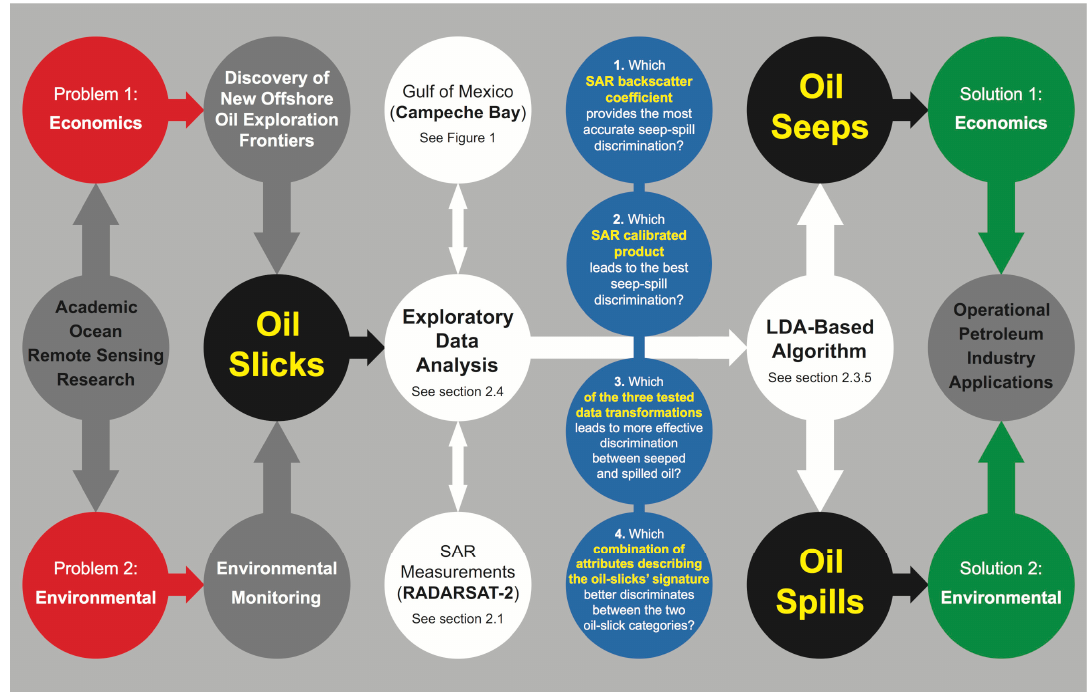
Figure 2. Research rationale of our exploratory data analysis aimed to try to improve the slick category discrimination (seeps vs. spills) using linear discriminant analysis (LDA) applied to synthetic aperture radar (SAR) measurements. Circles’ colors: gray, red, and green (bridge the knowledge of our academic ocean remote sensing strategy and operational applications of the offshore petroleum industry); black (our main objective: categorize slicks into seeps or spills); white (our exploratory data analysis: site-, data-, and algorithm-specific); and blue (our four scientific questions). SAR backscatter coefficient: sigma–naught ( σ o ), beta–naught ( β o ), and gamma–naught ( γ o ). SAR calibrated product: reflected radar beam given in amplitude ( amp ) or in decibel ( dB ), with or without a despeckle filter. Data transformations: none, cube root, and log 10 . Oil-slicks’ signature: size information and SAR basic qualitative-quantitative statistics.